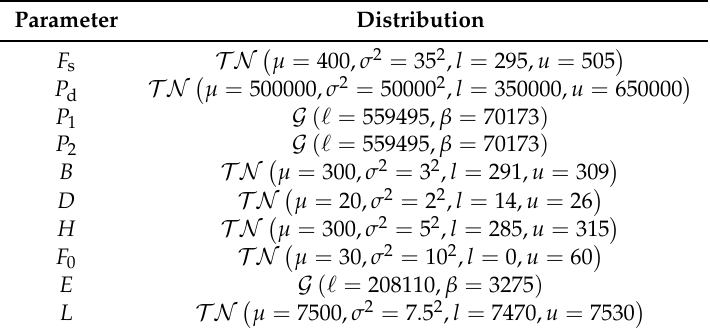
Table 1. Parameter distributions of the steel column function.